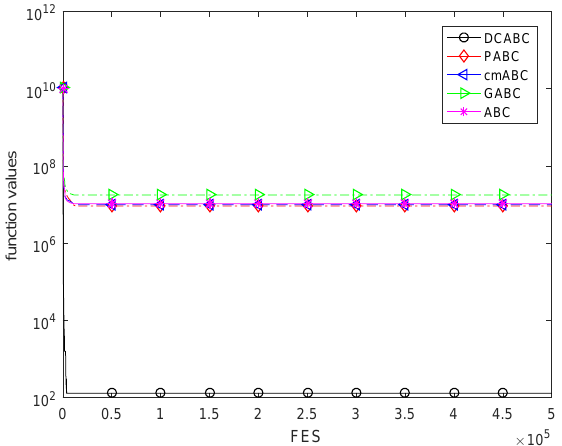
Figure 4. Convergence curves of five algorithms for f 1 with D = 50. (The optimal value of f 1 is 100).